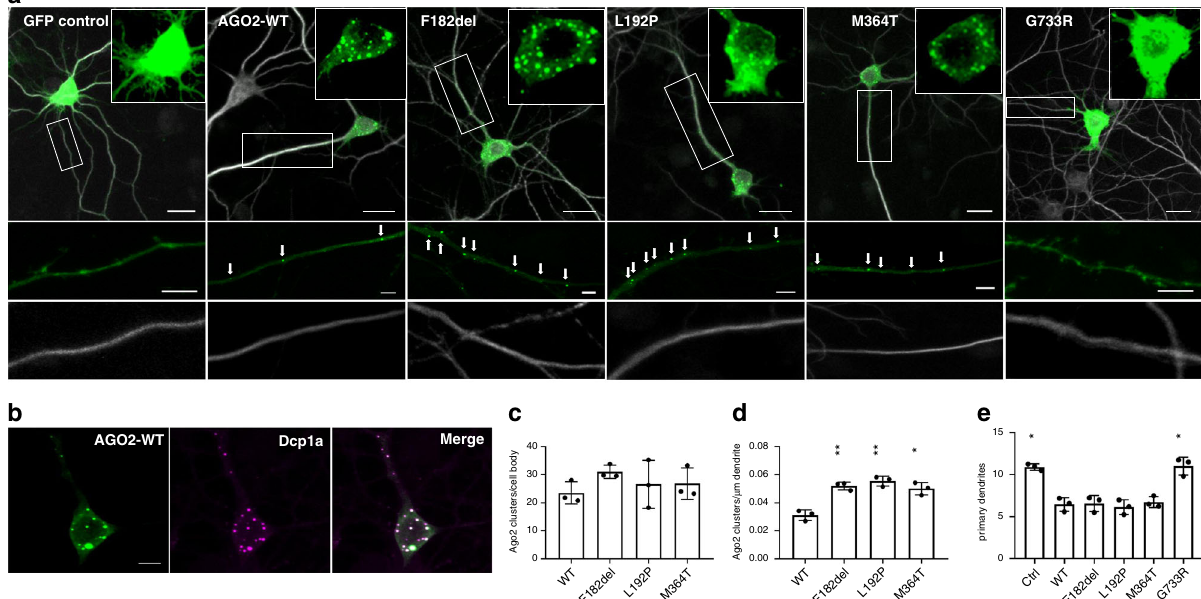
Fig. 5 AGO2 germline mutations lead to an increased number of dendritic P-bodies. a Primary cultured murine hippocampal neurons were transfected with GFP control or GFP-AGO2 WT and variants and Tomato-red. Staining for the dendritic marker MAP2 is shown in gray; inserts display the GFP signal in cell bodies. Boxed areas are magni fi ed below for GFP- and MAP2 signals. Arrows indicate dendritic GFP-AGO2 clusters. Similar results were obtained in three independent biological experiments; results are quanti fi ed in ( c , d , e ). Scale bars: 20 μ m in overview pictures; 5 μ m in inserts. b Neurons expressing GFP-AGO2 were co-stained for Dcp1a. Similar costaining results were obtained in two biologically independent experiments for wt and F182del, L192P and M364T mutants, with 30 cells analyzed per experimental condition Scale bar: 5 μ m. c – e Quanti fi cation of GFP-AGO2 clusters in cell bodies ( c ), GFP-AGO2 clusters in dendrites ( d ), and primary dendrites per cell ( e ). Data for mutant and control conditions were compared to wt. *, ** p < 0.05, 0.01, respectively; Brown – Forsythe and Welch one-way-ANOVA, followed by Dunnett ’ s T3 multiple comparisons test; n = 3; mean ± SD). Source data are provided as a Source Data fi